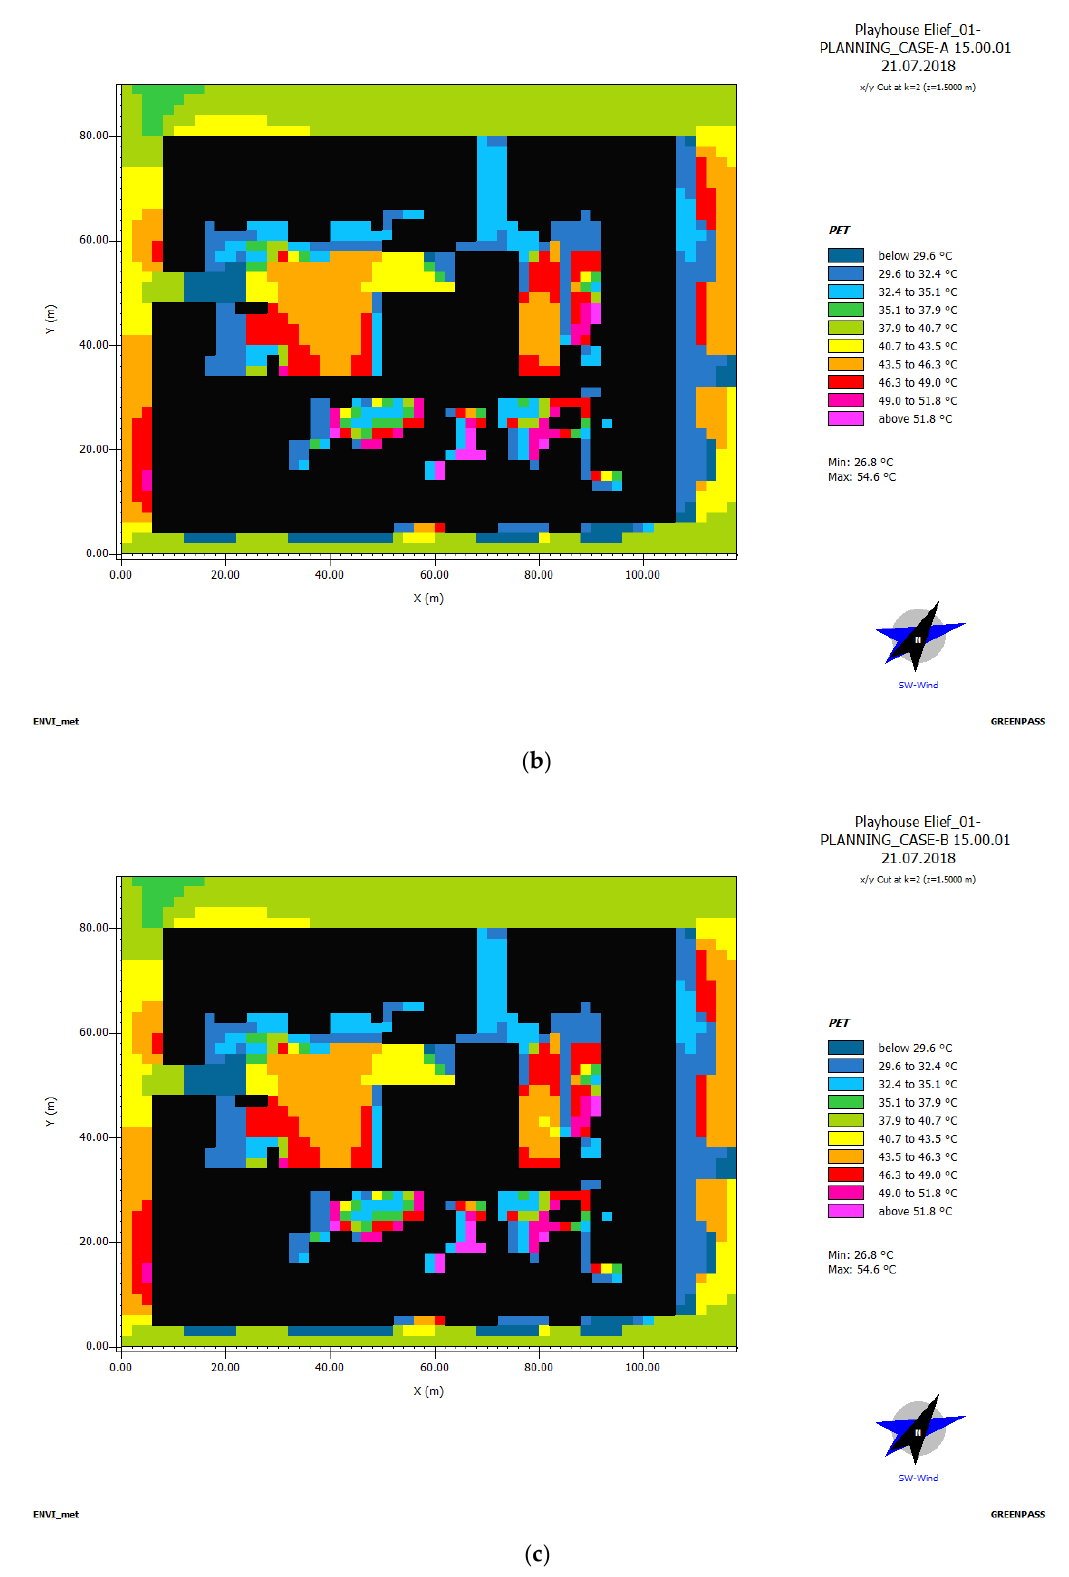
Figure 7. Results of microclimatic simulation Playhouse Elief Antwerp, comparison on a hot summer day 21.7. ( a ) Variant SQ—Physiological equivalent temperature (PET) 15:00 at ground level; ( b ) Variant A—PET 15:00 at ground level; ( c ) Variant B—PET 15:00 at ground